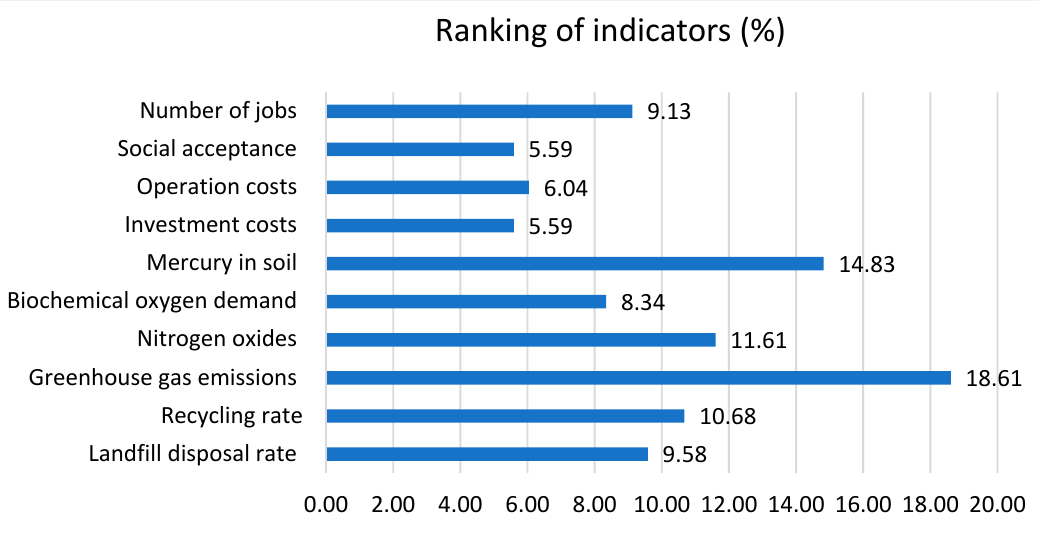
Figure 4. Ranking of indicators with respect to the goal.